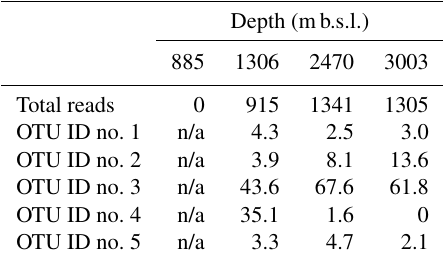
Table 5. Total Thaumarchaeota MG-I 16S rRNA gene reads and distribution per OTU (%) in surface